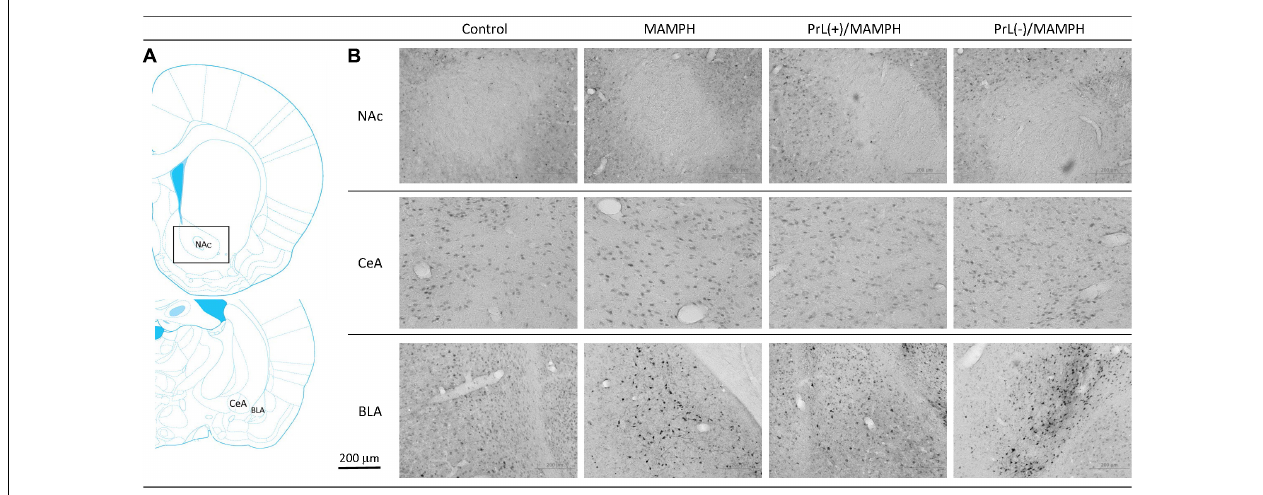
FIGURE 12 | (A) A schematic brain atlas for the NAc and the amygdala’s CeA and BLA. (B) Representative photomicrographs of p-ERK expression for the NAc and the amygdala’s CeA and BLA in the control, MAMPH, PrL(+)/MAMPH, and PrL(–)/MAMPH groups. The scale bar represents 200 µ